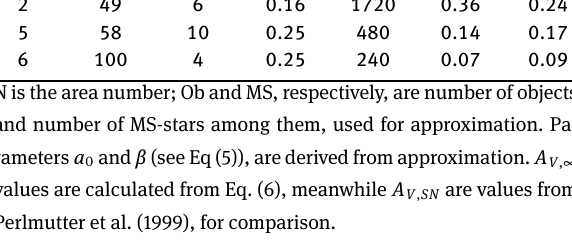
Fig. 4. A V ( d ) relation for area